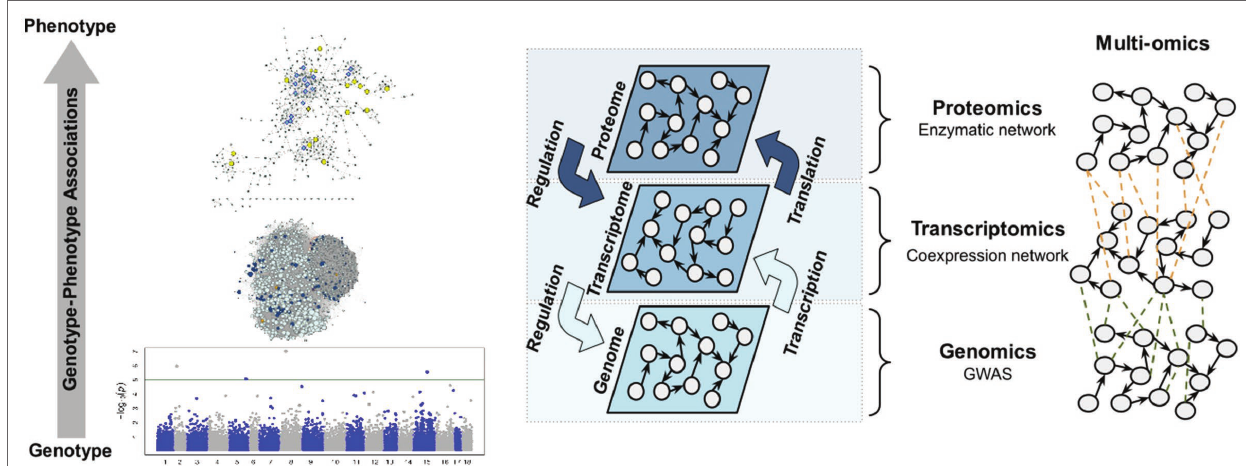
FIGURE 1 | Workflow summarizing the main analyses